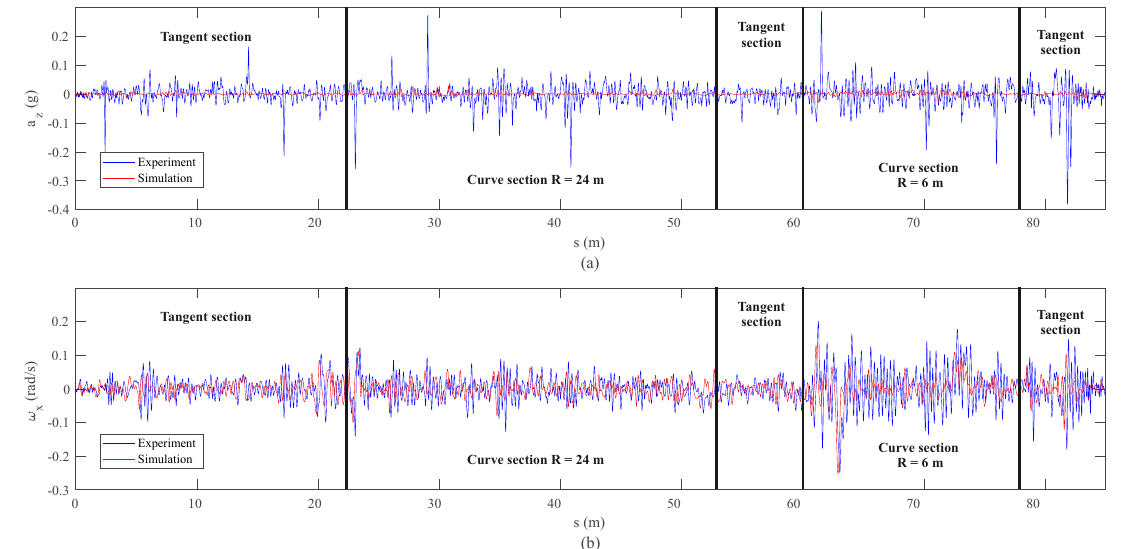
Figure 12. Vertical acceleration ( a ) and roll angular velocity ( b ) data from inertial sensors on the wheelset.